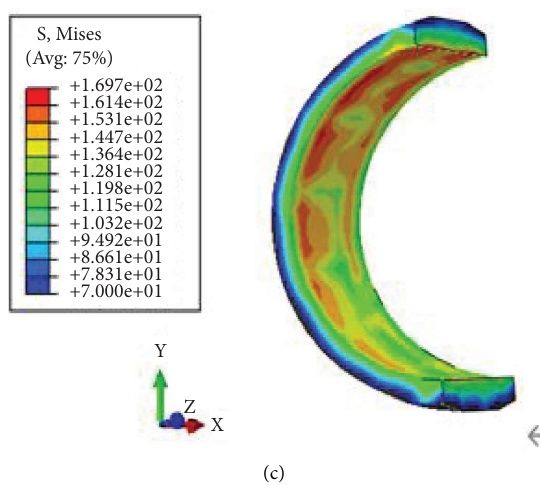
Figure 10: Bearing stress distribution (the unit is MPa).